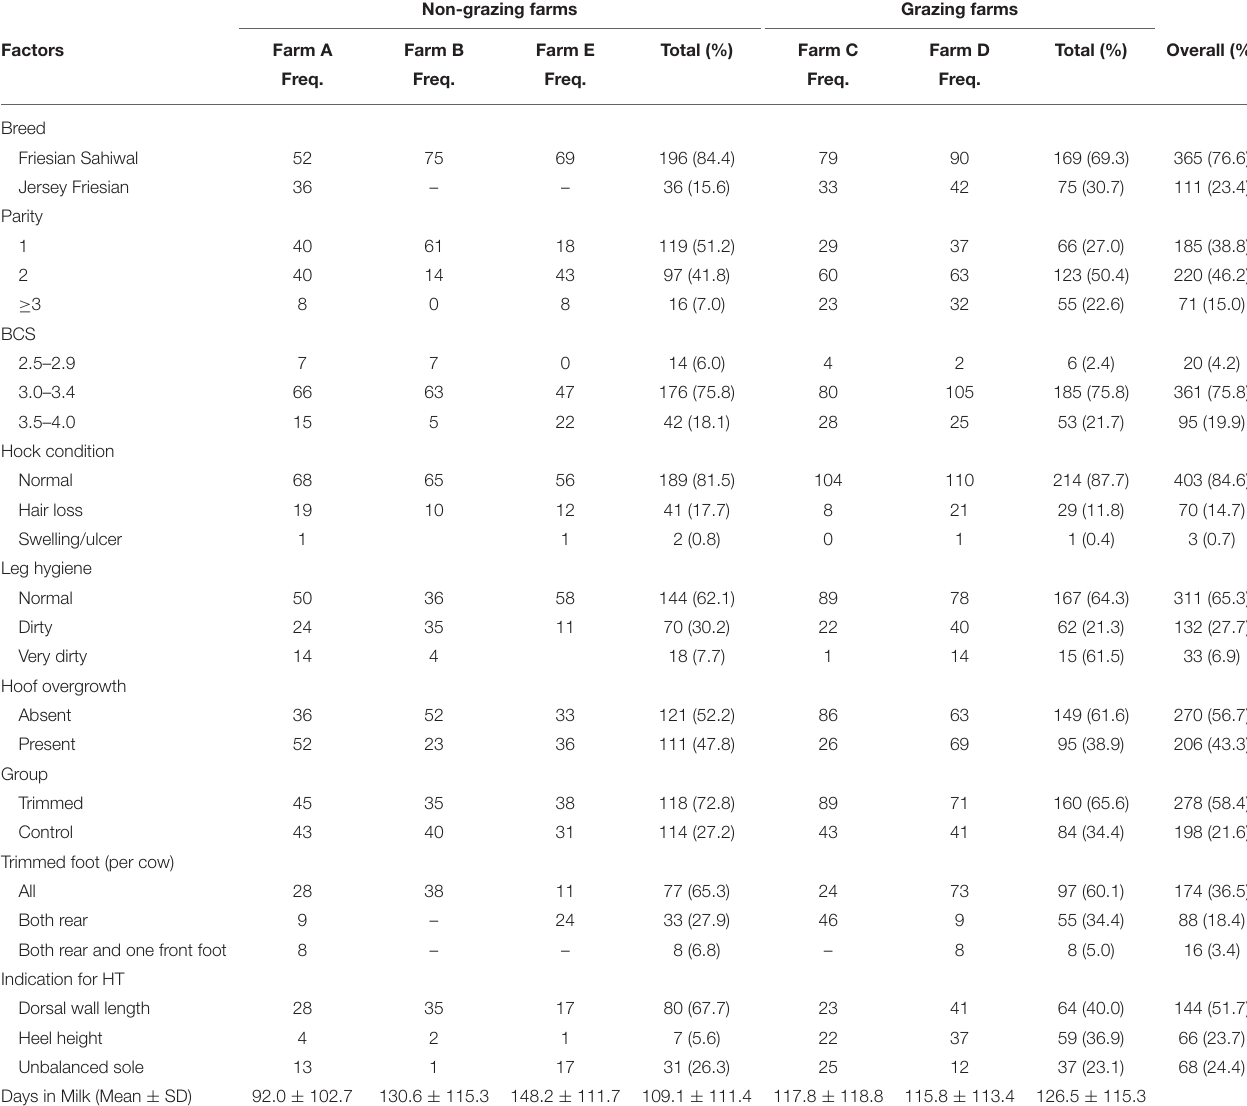
TABLE 2 | Characteristics of all the enrolled cows ( n = 520) in grazing and non-grazing dairy farms. Non-grazing farms Grazing farms Factors Farm A Farm B